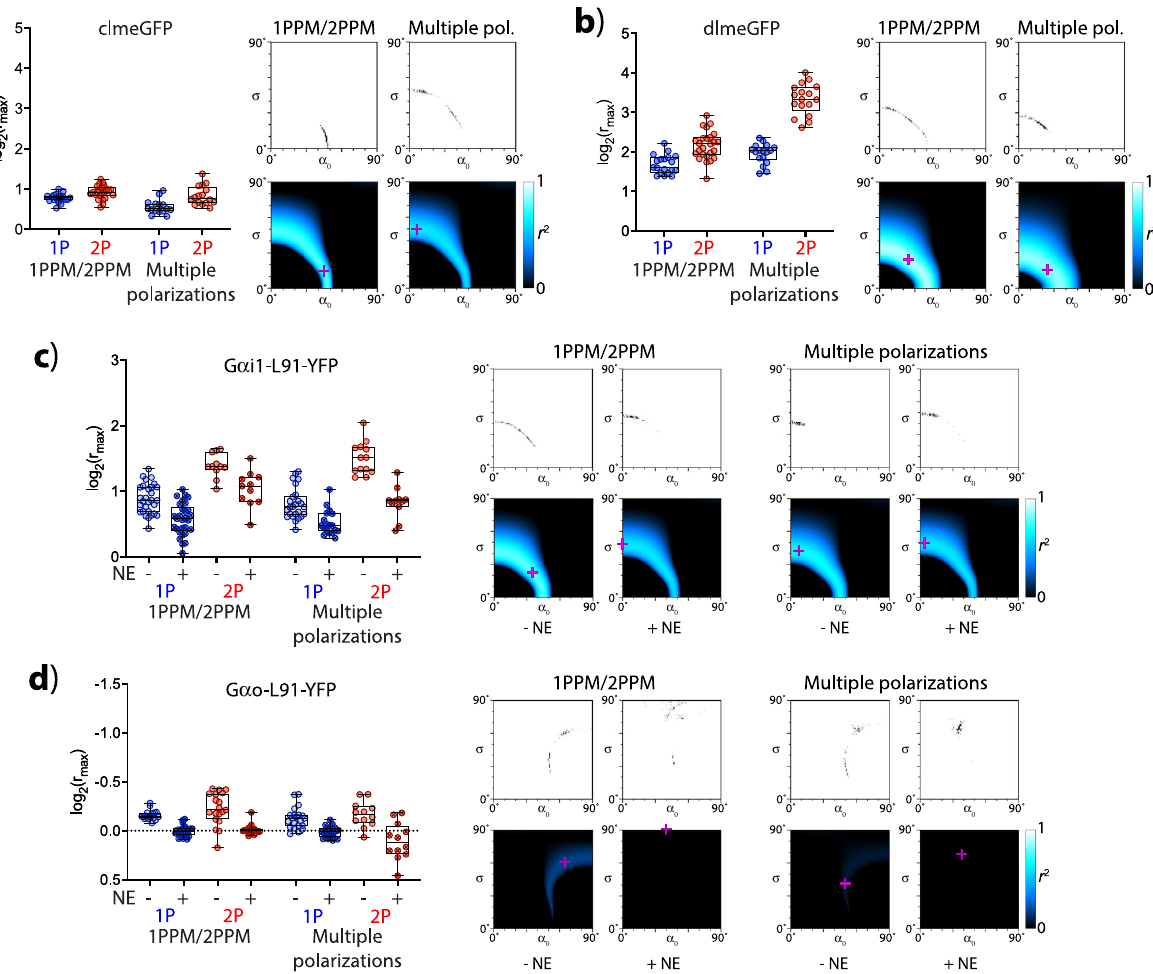
Fig. 8 Quantitative polarization microscopy imaging of intact, living cells. a Cells expressing the model lipidated fl uorescent protein construct clmeGFP. Left: a plot of log 2 ( r max ) values obtained from 1PPM, 2PPM, and from multiple polarization measurements using 1P and 2P excitation, with median values, 25 th and 75 th percentiles, and ranges shown; Right: plots showing combinations of α 0 , σ consistent with combined 1PPM/2PPM, and 1P/2P multiple- excitation polarization observations (top: 95% con fi dence interval estimates obtained by bootstrapping, bottom: heat-maps of goodness of fi t, described by the coef fi cient of determination r 2 ). The α 0 , σ combination in best agreement with microscopy data is indicated by a magenta cross. b Same as a , but for dlmeGFP. c Same as ( a ) and ( b ), but for G α i1-L91-eYFP, before and after activation by norepinephrine (NE). d Same as ( c ), but for G α